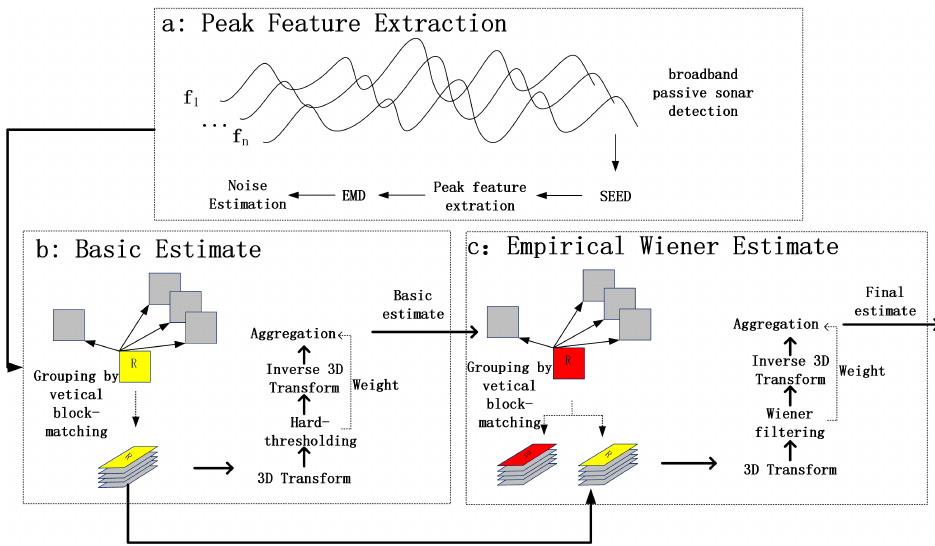
Figure 1. Frame of proposed